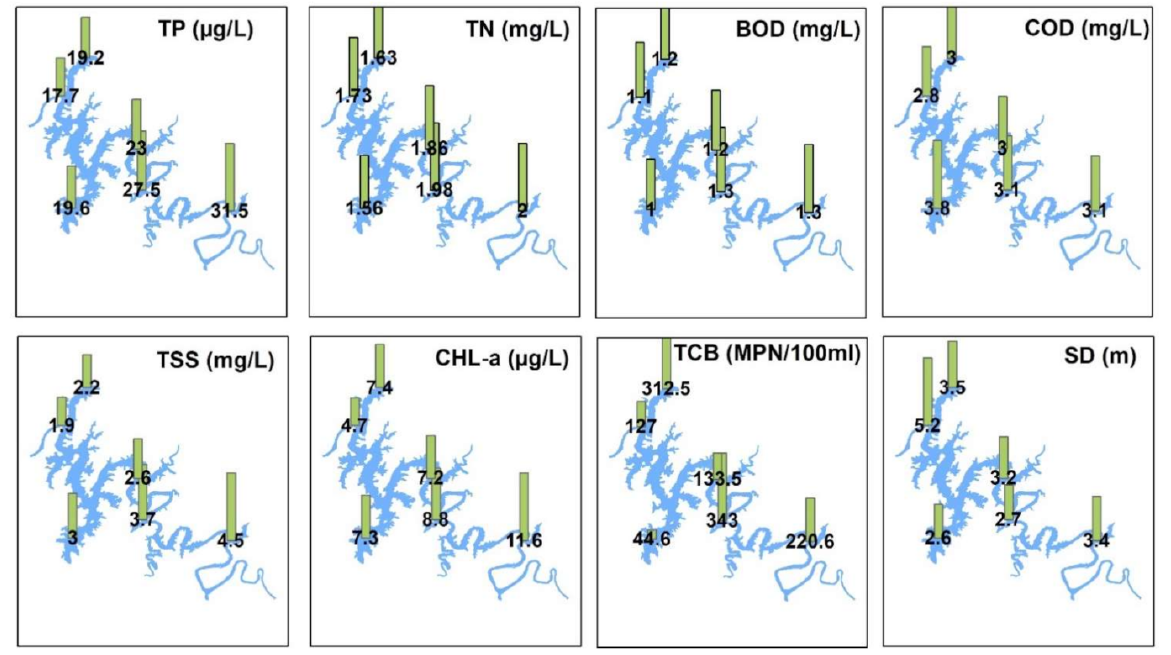
Figure 3. Spatial variations of water quality parameters at the reservoir zones and water intake towers. TP: total phosphorus, TN: total nitrogen, BOD: biological oxygen demand, COD: chemical oxygen demand, TSS: total suspended solids, CHL-a: chlorophyll-a, TCB: total coliform bacteria, SD: Secchi depth. For site identification, please refer to Figure